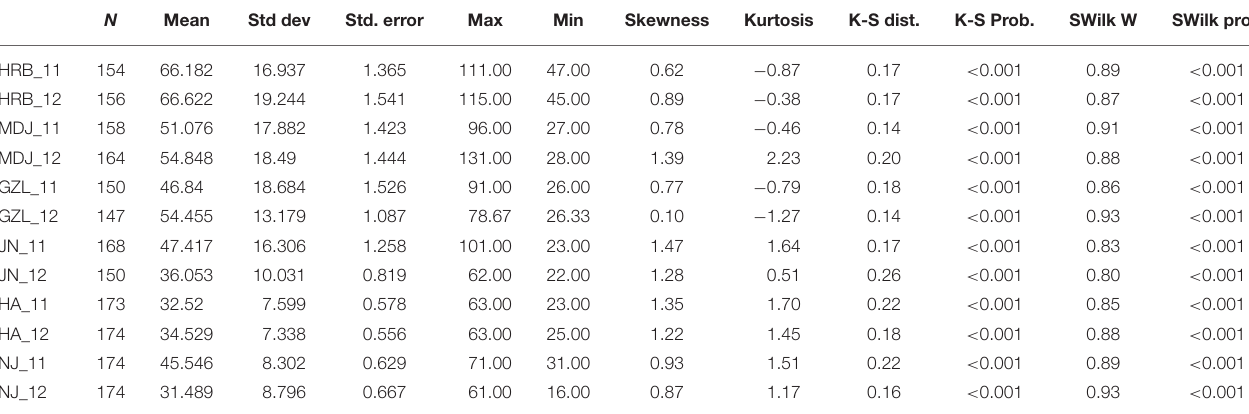
TABLE 1 | The basic statistics of flowering time (R1) of cultivars grown at different locations in 2011 or 2012.